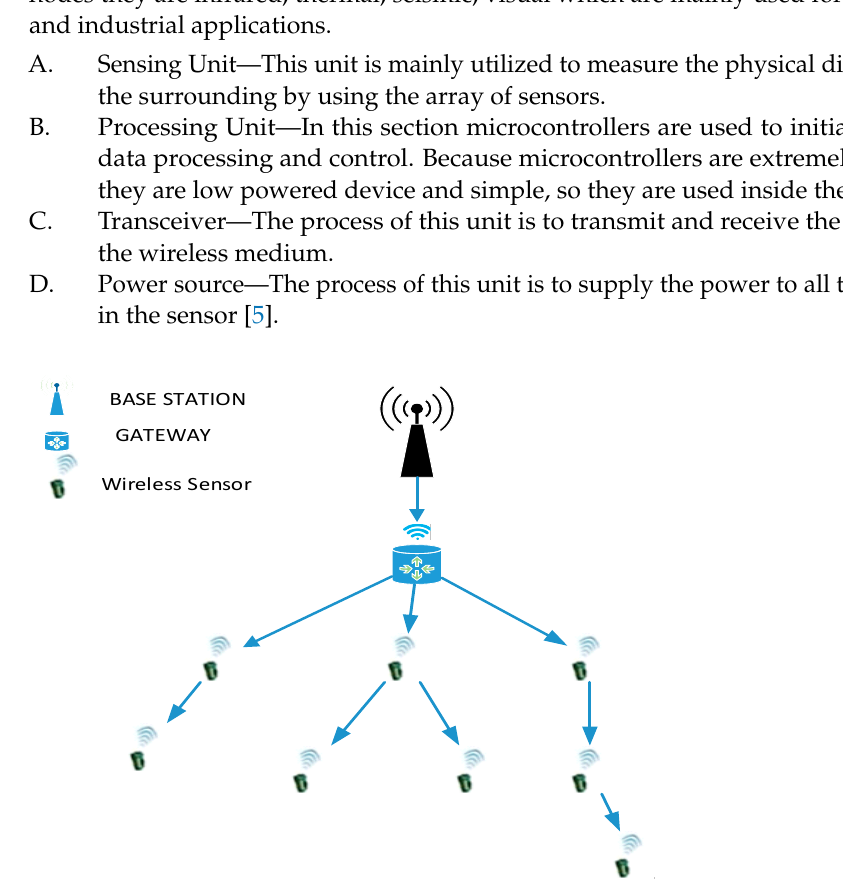
Figure 1. Architectural topologies of wireless sensor networks.